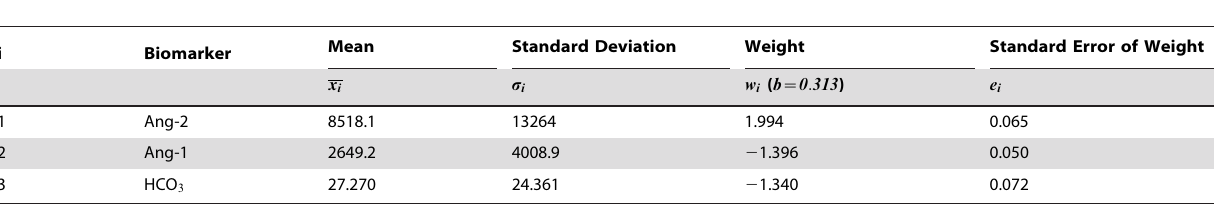
Table 3. Parameters for the decision function that includes the CCA-selected optimal subset of biomarkers at k ~ 3 .